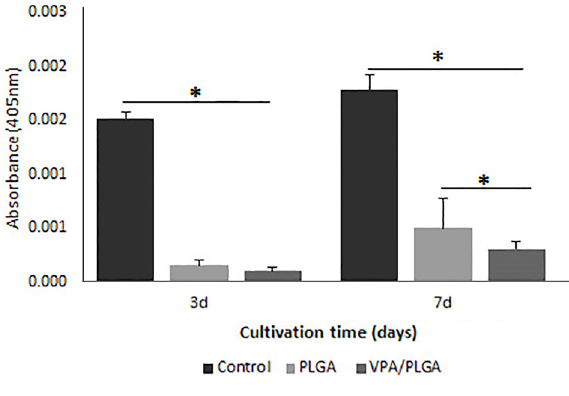
Figure 5. Analysis of cell viability on the poly(lactic-co-glycolic acid) (PLGA) and valproic acid (VPA)/PLGA scaffolds by WST-8 assay. The absorbance value (405 nm) was measured at 3 and 7 days in culture. Data are reported as means ± SD (n=3). *P o 0.05, one-way ANOVA.